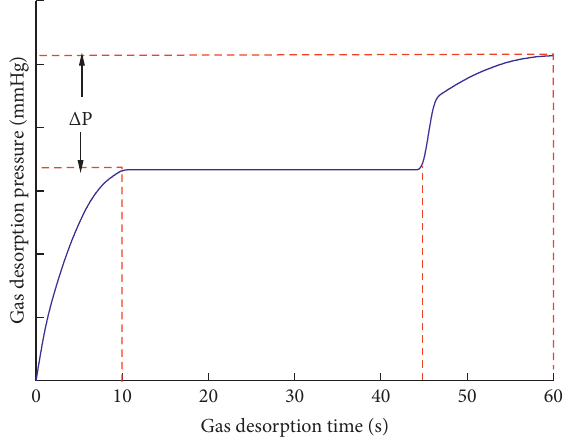
Figure 5: An example of pressure variation.